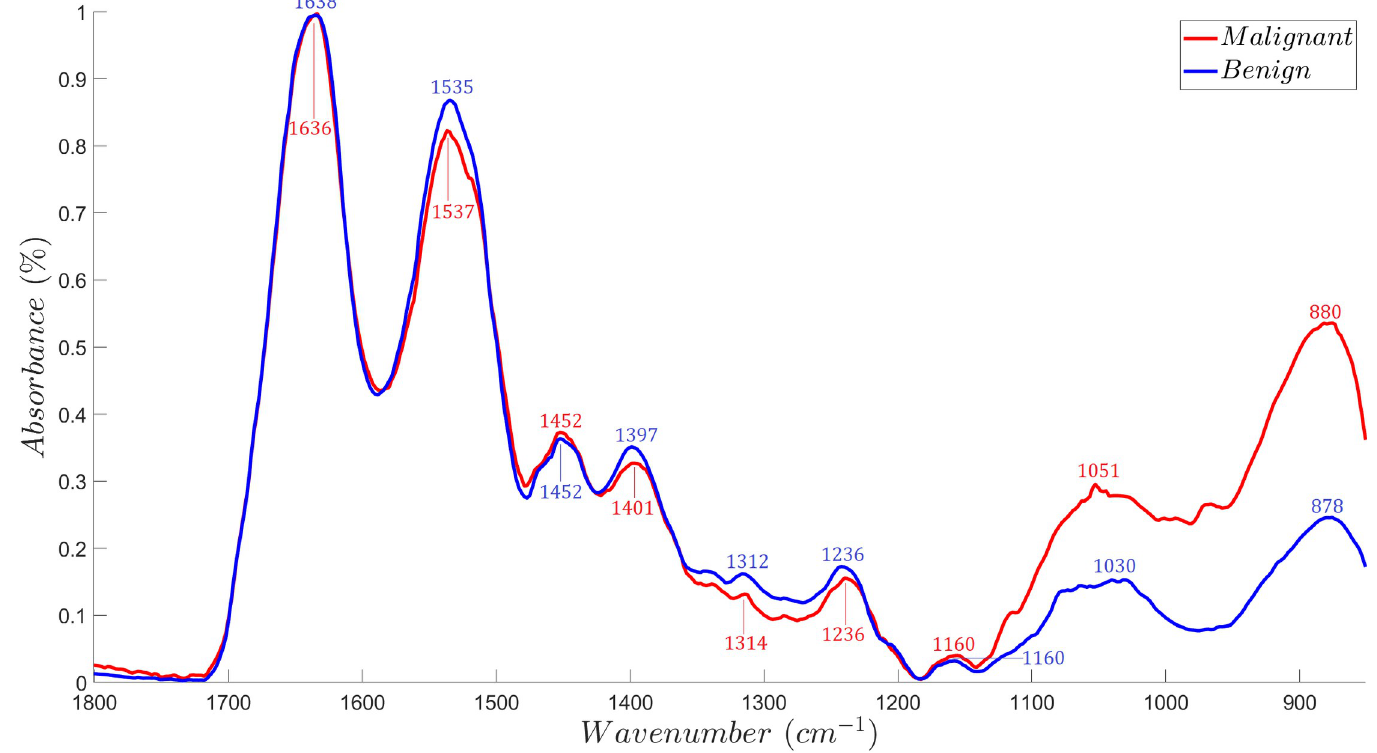
Fig 5. Median ATR-FTIR absorbance spectra of malignant ( n = 53) and benign ( n = 65) lung tissue samples. The figure shows the median FTIR spectrum of malignant and benign lung tissue samples and their corresponding peaks identified via visual analysis.